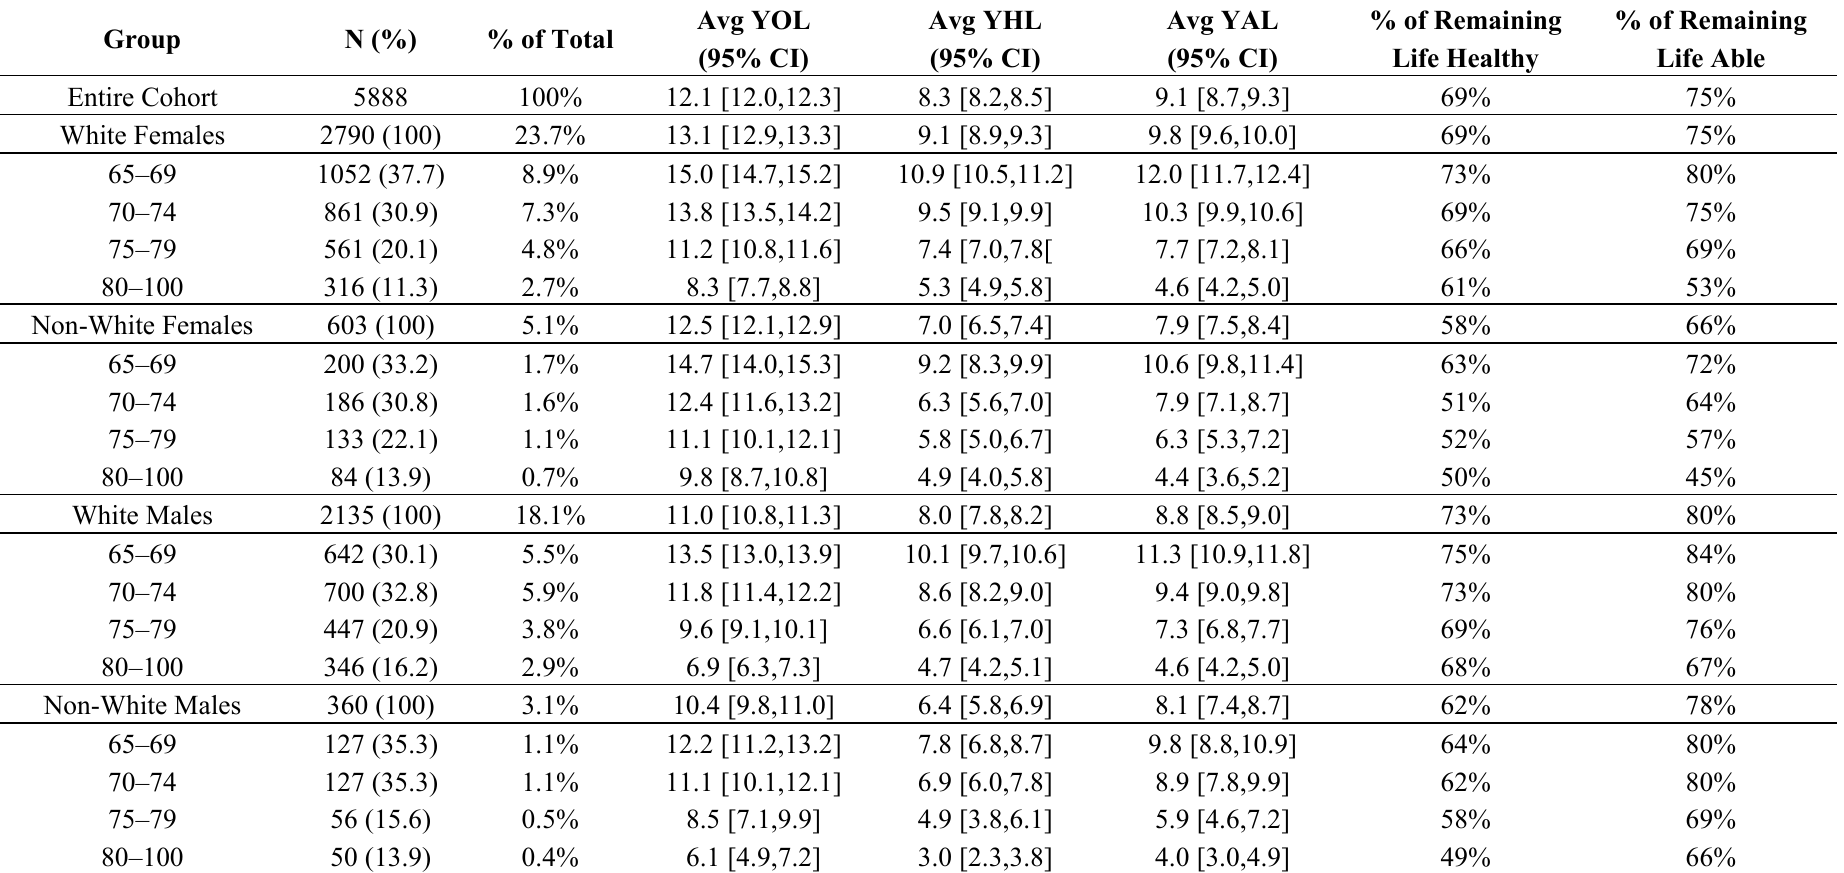
Table 1. Distribution of the cohort at baseline, and average values of years of life, years of healthy life, and years of able life for each group and subgroup, with 95% confidence intervals shown in